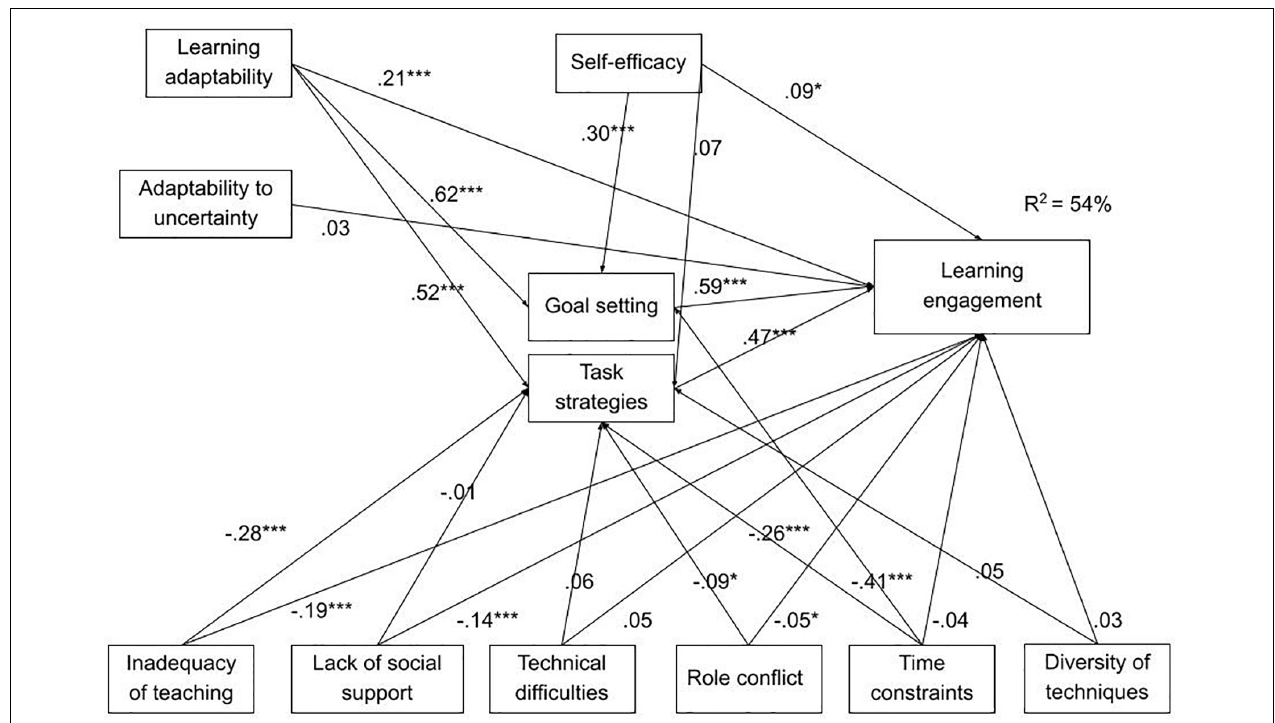
FIGURE 2 | Path coefficients for the mediation model. * p < 0.05, *** p <